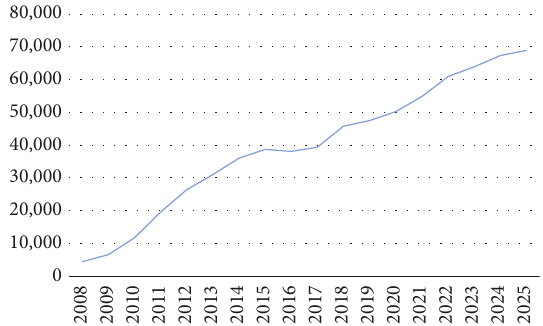
Figure 7: Solar energy supply in Germany by year, gigawatts per hour. Source: IEA; author’s calculations.